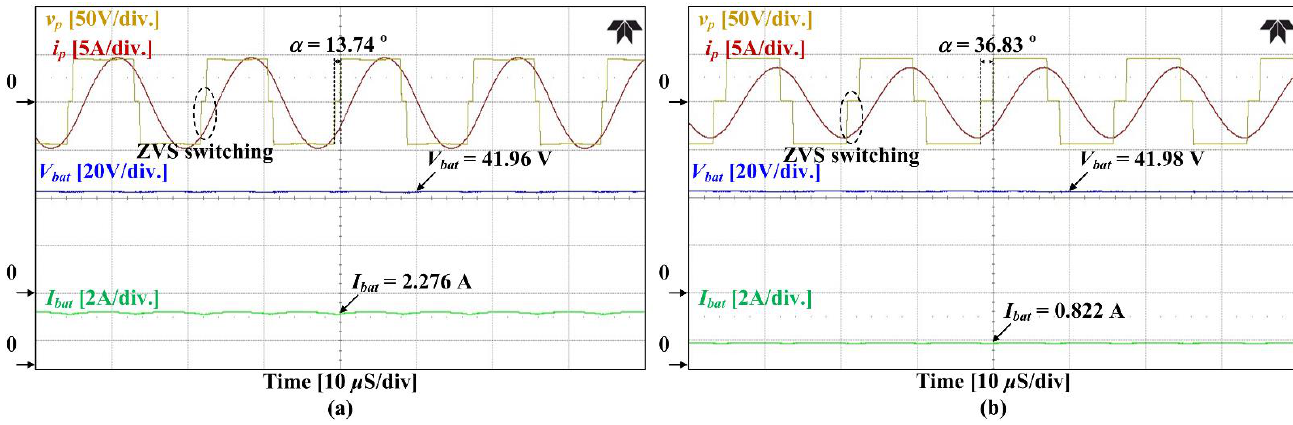
Figure 12. Experimental waveforms when the proposed WPT circuit operates in the CV mode with f s = f CV at ( a ) R bat = 18.29 Ω, and ( b ) R bat = 41.53 Ω.